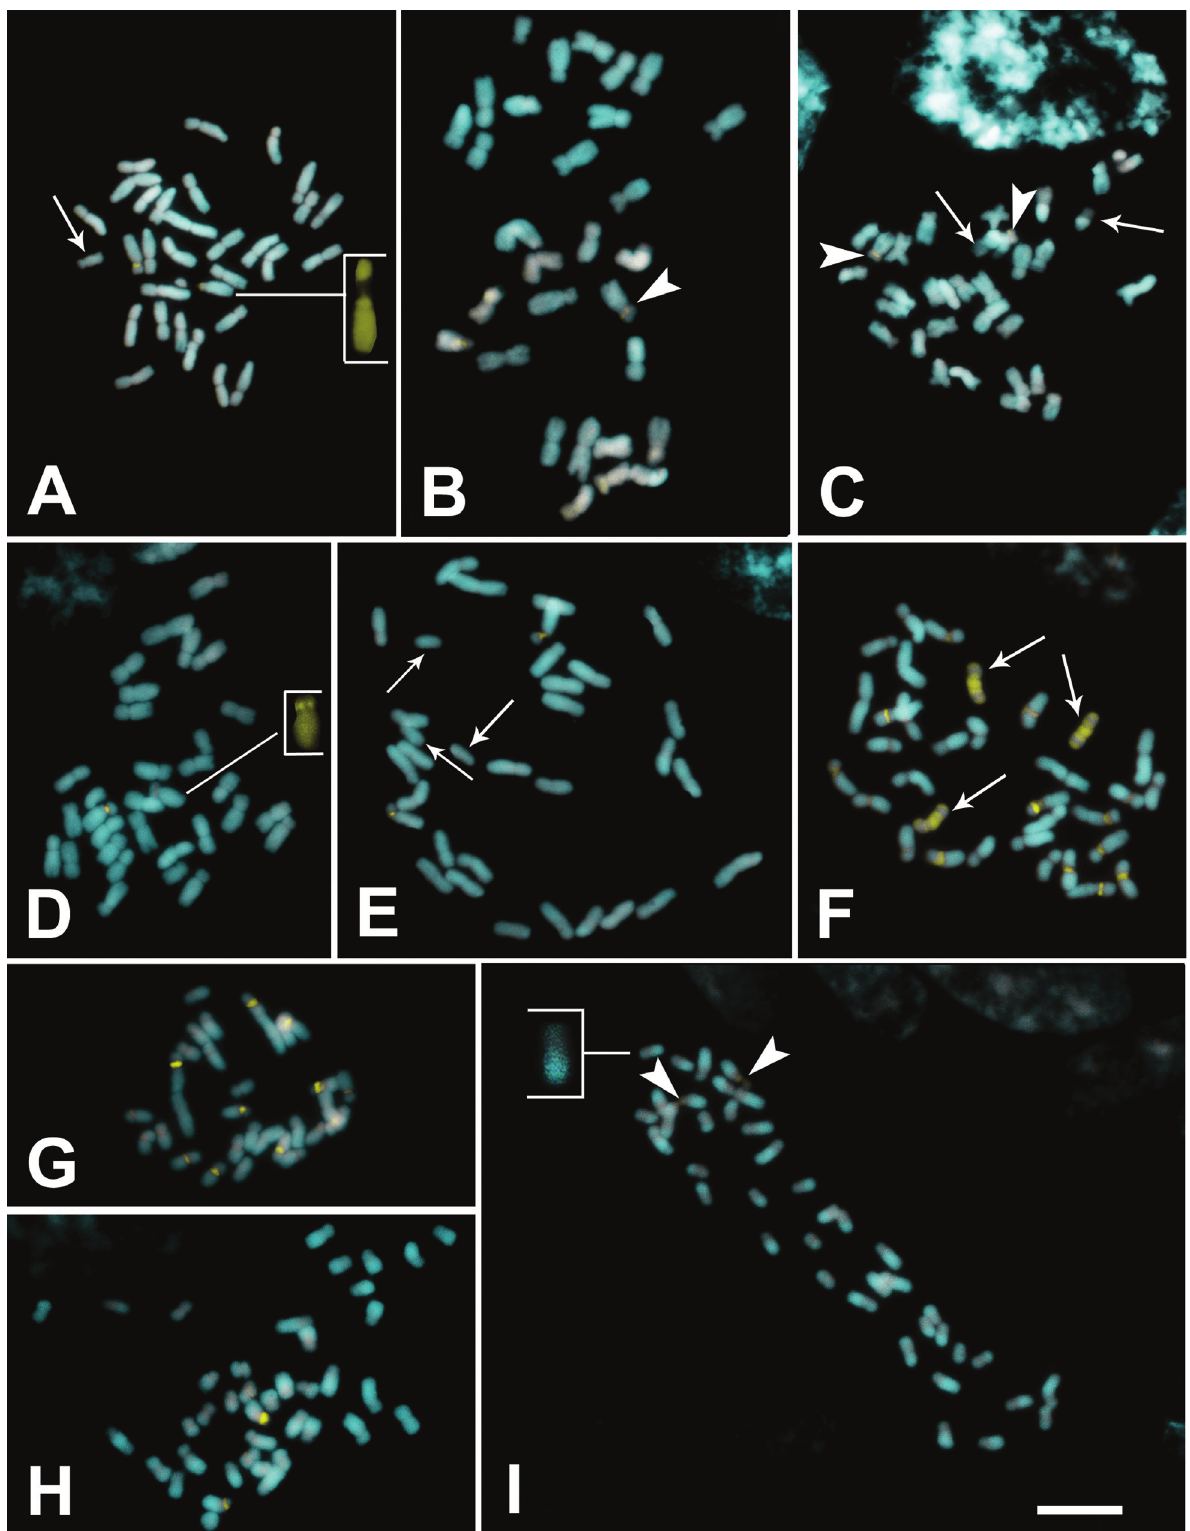
Figure1 -Metaphasesof Anthurium speciesunderCMA/DAPIstaining.(A-E) Anthuriumaffine .(A)Queimadas-PBpopulationwith2 n =30+1B;(B-C) Águas Belas-PE population, with 2 n = 30 (B) and 2 n = 30+2Bs (C); (D-E) Andaraí-BA population with 2 n = 30 (D) and 2 n = 30+3Bs (E); (F) A. gladiifolium (2 n = 30+3Bs); (G-I) A. gracile . Senhor do Bonfim-BA population with 2 n = 30 (G), Mamanguape-PB (H) and Peruíbe-SP population (I), both with 2 n = 40. Arrows in A, C, E and F show B chromosomes; arrow heads in B, C and I show minor CMA bands; inserts in A and D highlight chro- mosomes with CMA bands; inserts in I show chromosomes with DAPI + / CMA 0 blocks. Bar in I is equivalent to 10 (cid:2)